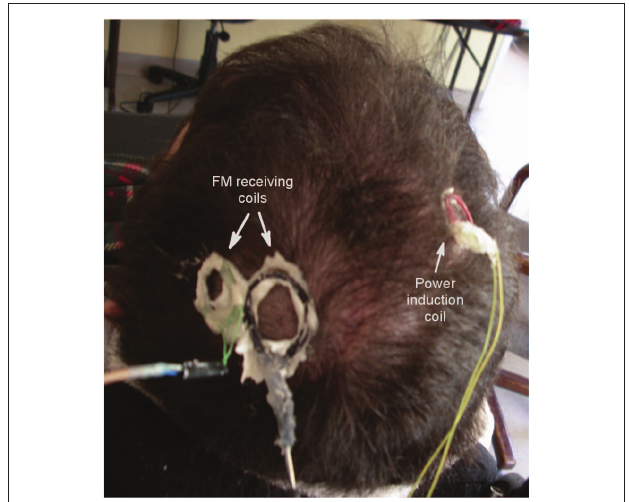
Figure 1 | The power induction coil is on the right side, with the two FM receiving coils on the left. All coils are held in position with EC2 electrode